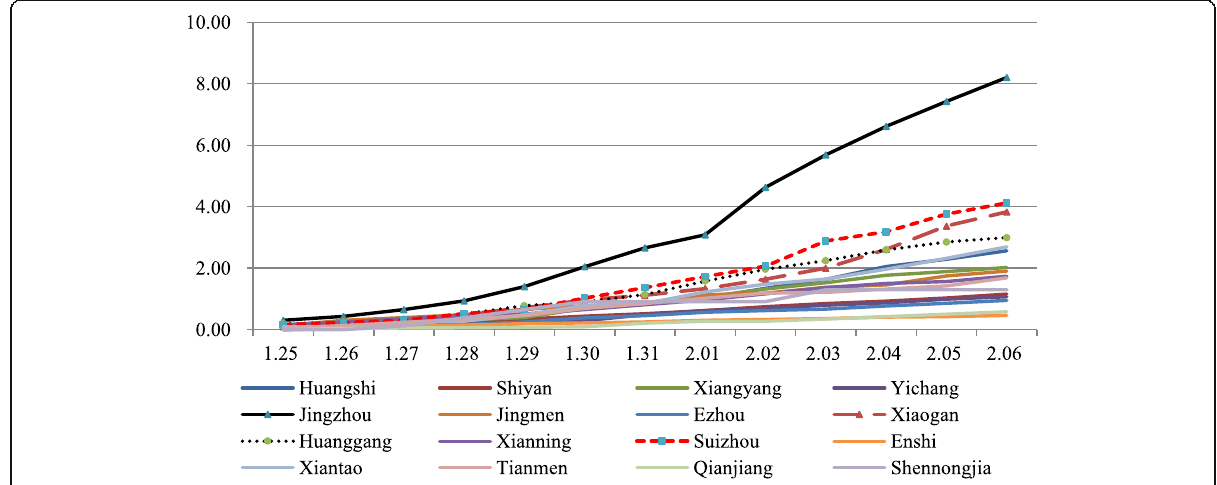
Fig. 2 Cumulative diagnosis rate per 10,000 persons of COVID-19 in 16 prefecture-level cities in Hubei Province from January 25th to February 6th,